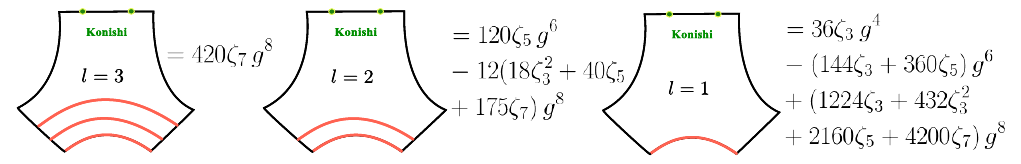
Figure 17 . Four-loop result for c